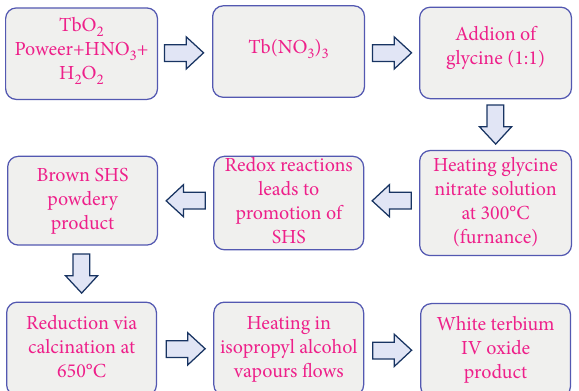
Figure 1: Schematic illustration of terbium IV oxide synthesis of by SHS.